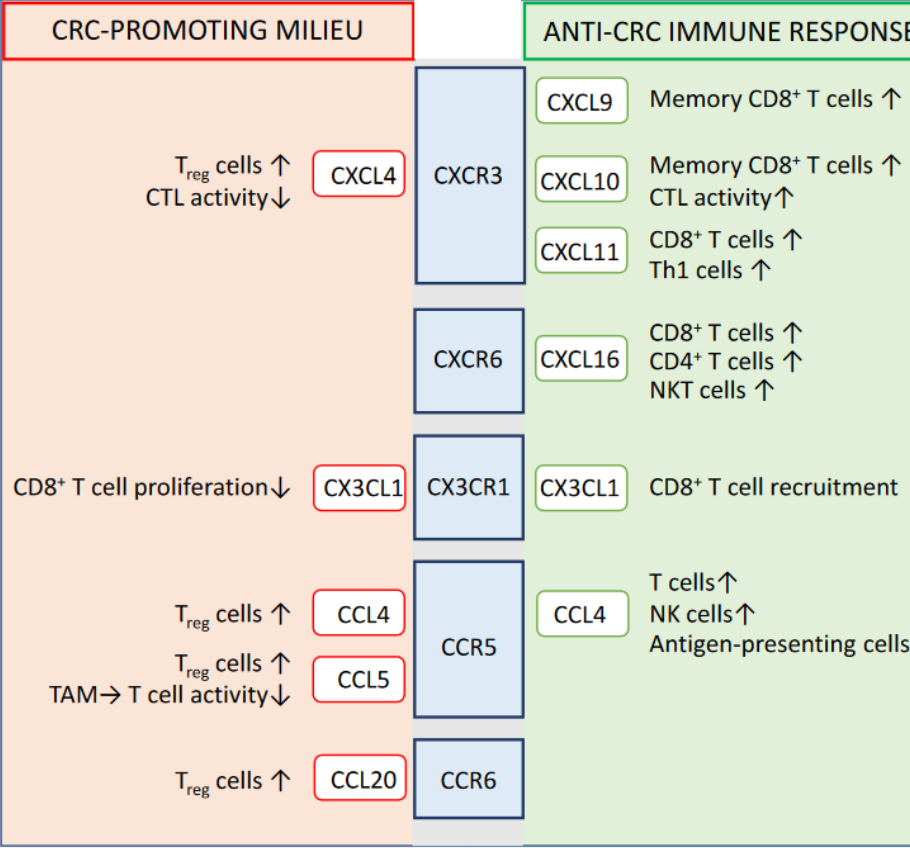
Figure 1. Chemokine signaling of described relevance for the immune system-mediated control of CRC. Abbreviations: TAM = tumor-associated macrophages; CTL = cytotoxic T lymphocytes; ↑ = increased; ↓ = decreased.